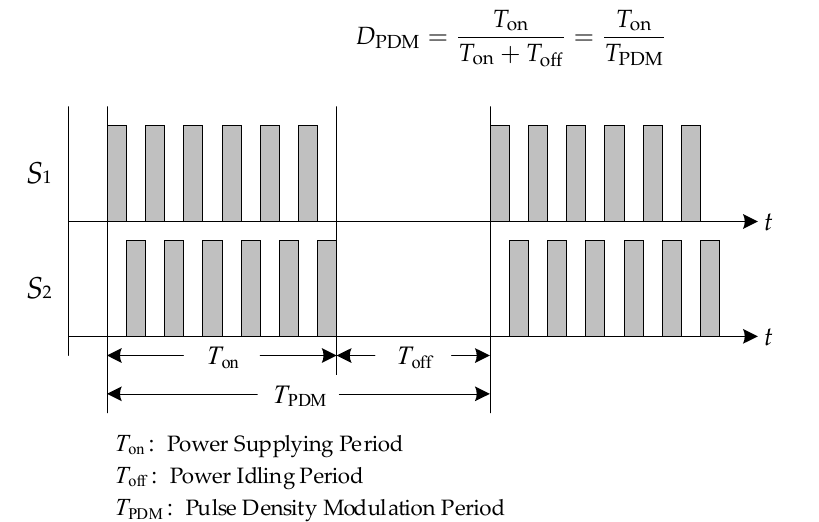
Figure 4. PDM control gate pulse sequences.